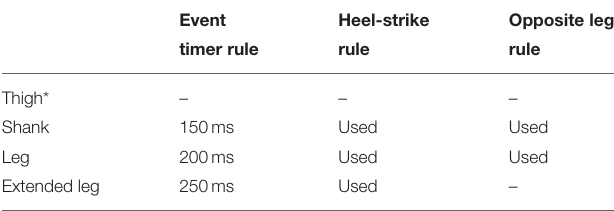
TABLE 1 | Rule sets applied to the different lower limb